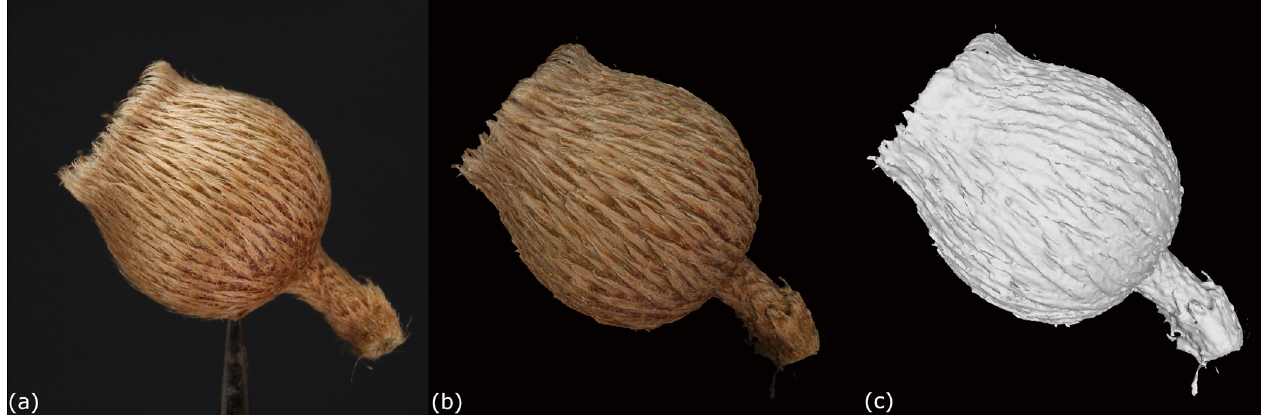
Fig 7. A comparison of the indumentum of 3D models and the carpological materials. (a) Side view of a carpological material of Melastoma malabathricum Linnaeus. (b) Side view of the 3D model PH193. (c) Side view of the mesh with texture turned off.